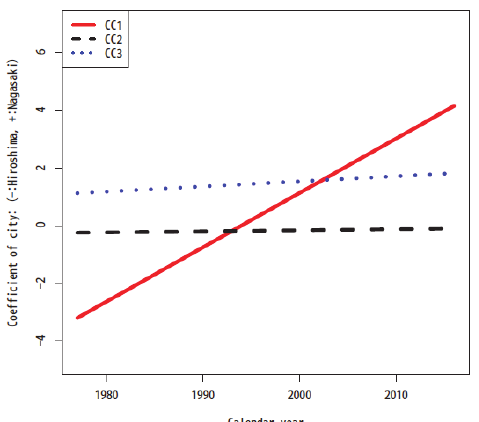
Fig. 16. Estimates and 95% simultaneous CI of regression coefficient in "State"